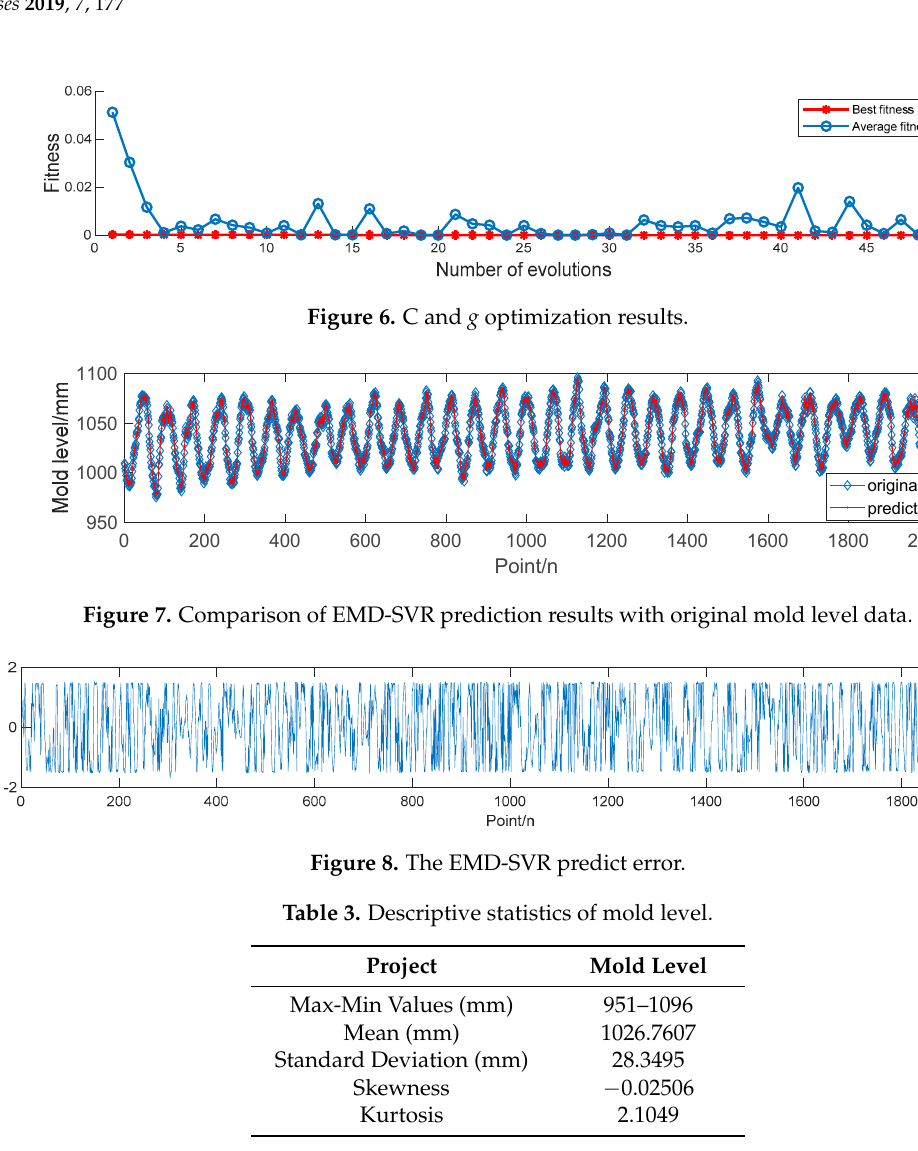
Table 4. Parameter values of the model. ACF is Autocorrelation coefficient, PACF is Partial autocorrelation coefficient.